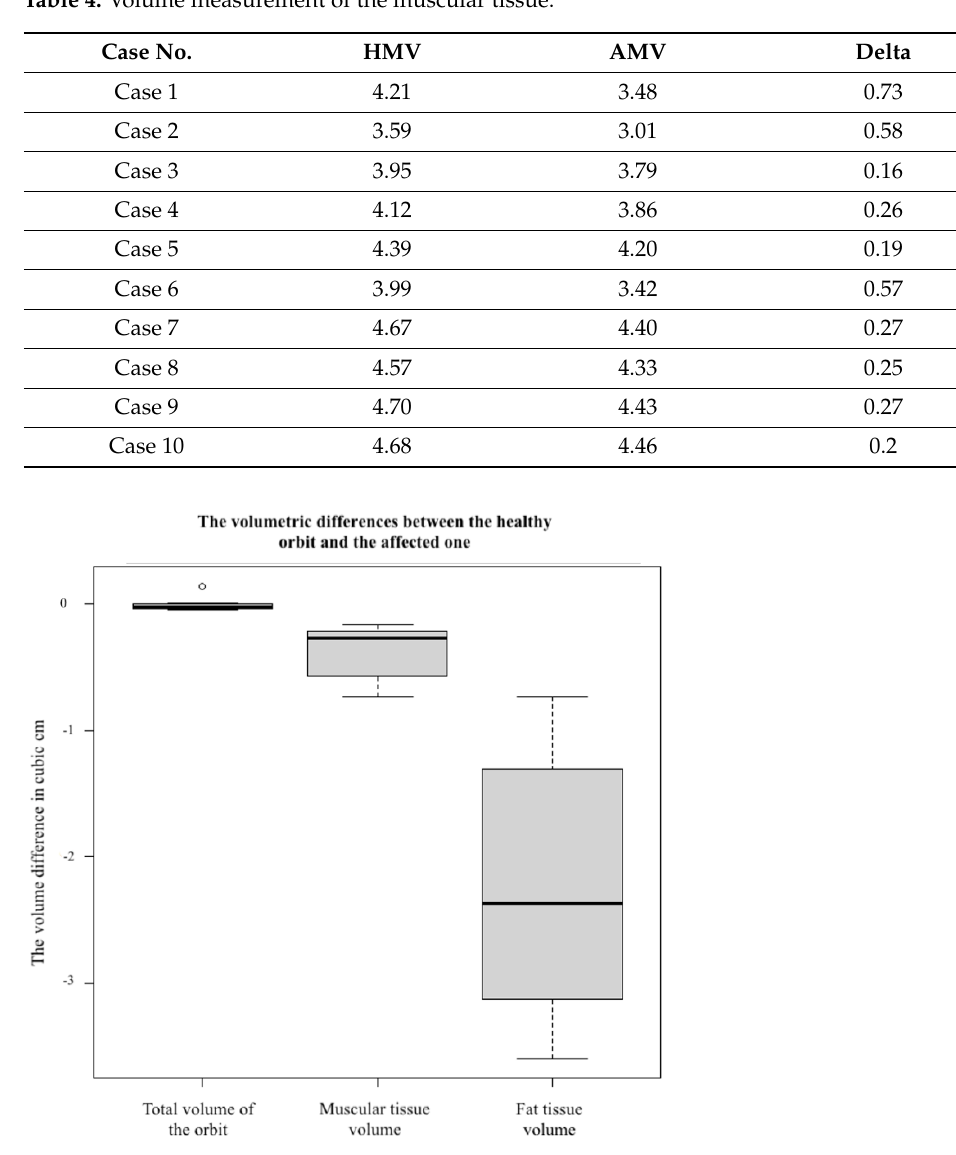
Figure 7. Volumetric differences between the healthy orbit and the affected one. Table 2. Volume measurement of the bony orbit. Case No.